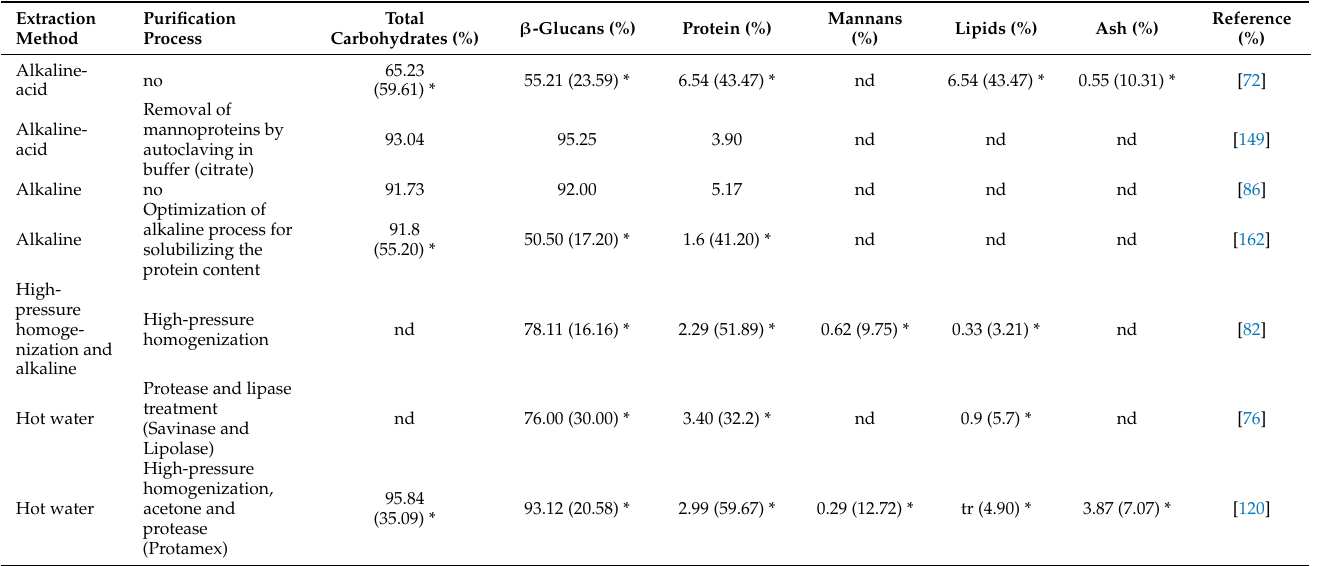
Table 1. Chemical composition of β -glucans extracted from residual brewer’s yeast by different